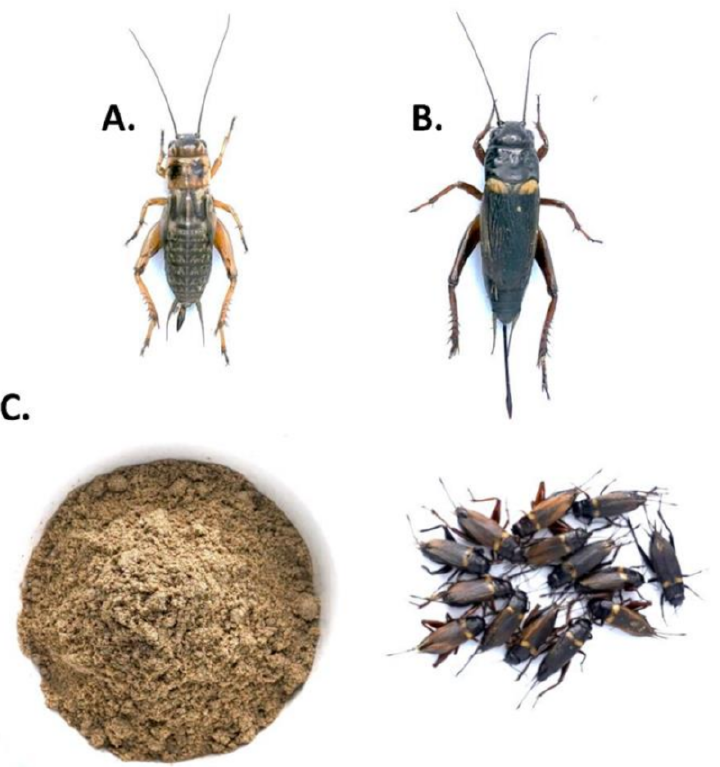
Figure 2. A representative image of ( A ) Acheta domesticus , ( B ) Gryllus bimaculatus and ( C ) Cricket powder made from G. bimaculatus